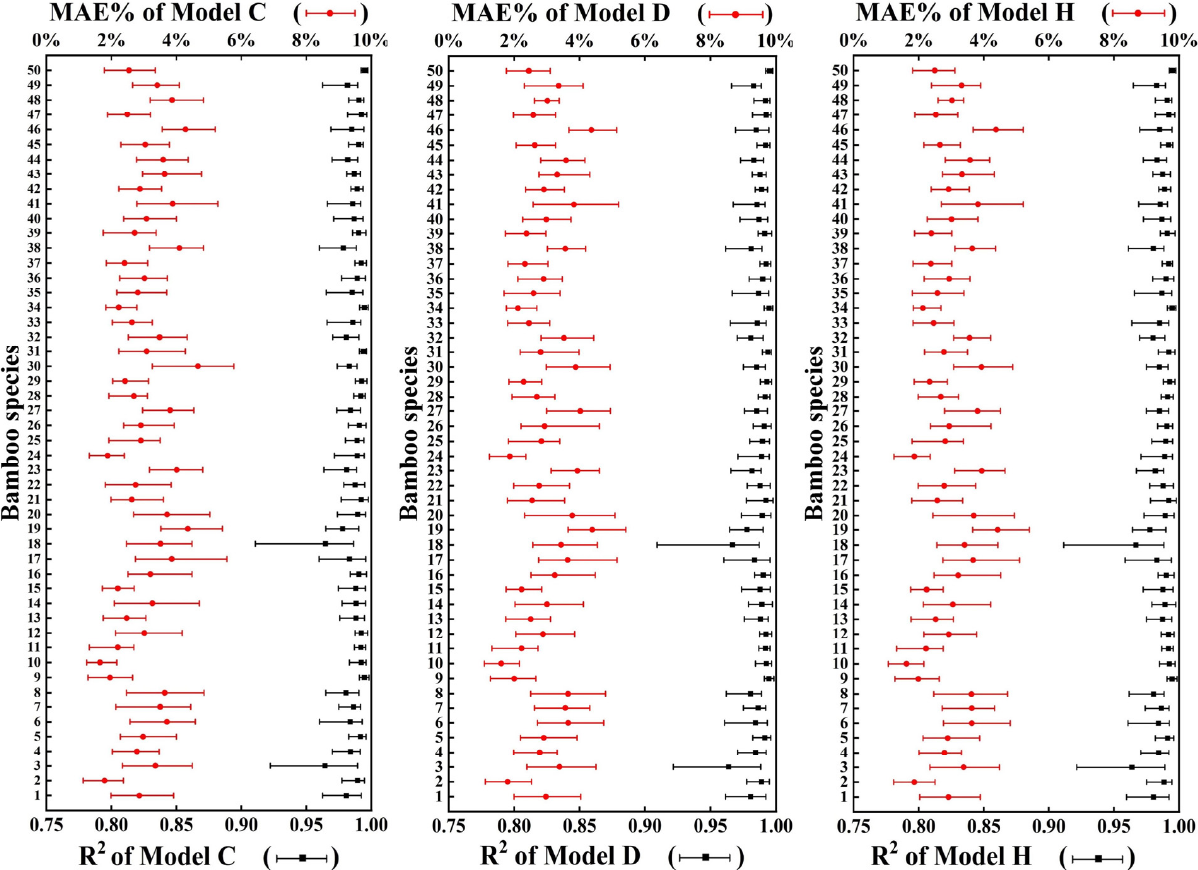
Figure A1. Validation of three selected models for LA estimations at leaf scale. Black spots and error bars represent the mean value and range of R 2 based on 40 model repetitions. Red spots and error bars represent the mean value and range of MAE % based on 40 model repetitions.